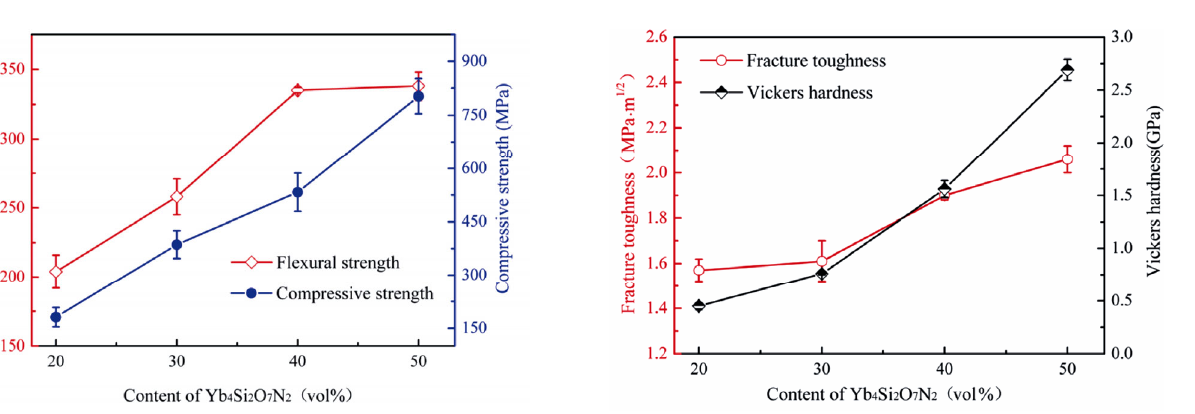
Fig. 3 TEM images of BYb40 composite: (a) bright-field image, (b) partly magnified image, and (c) HRTEM image of interface indicated by rectangle in (b).